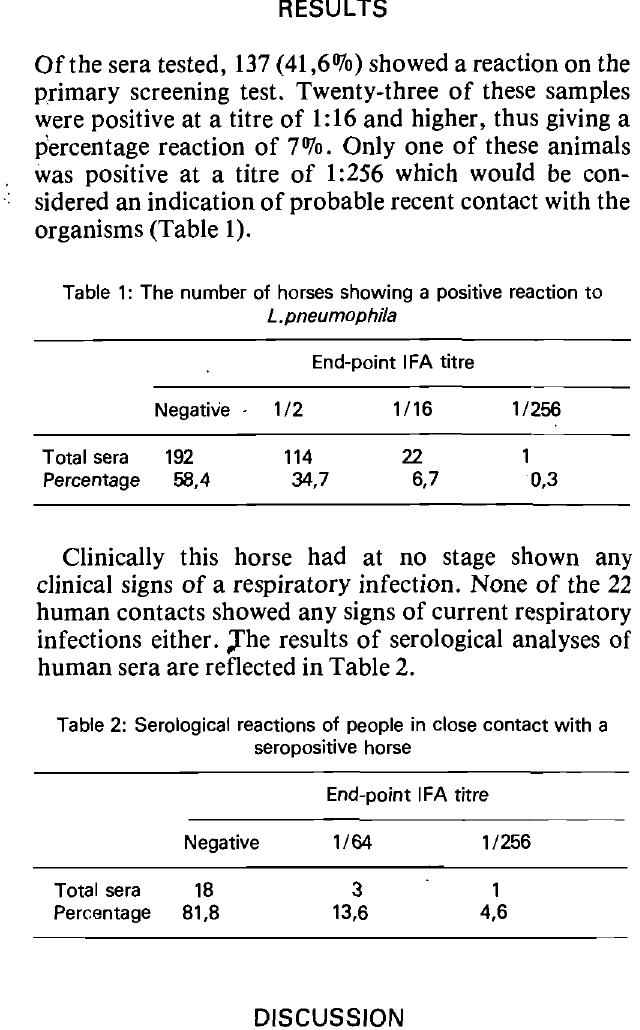
Table 2: Serological reactions of people in close contact with a seropositive horse